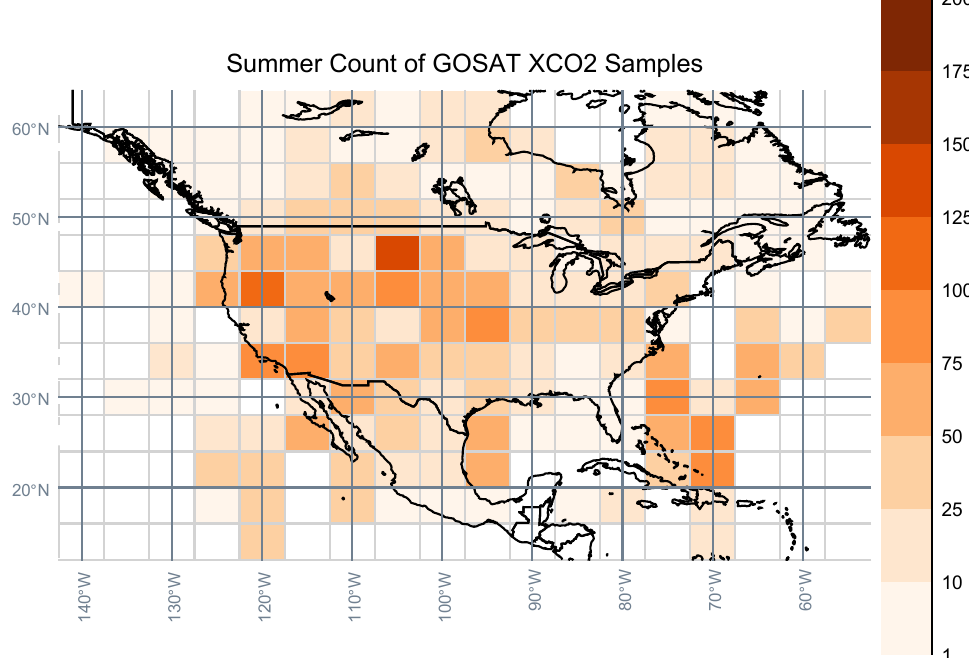
Figure A3. GOSAT XCO 2 sample counts for summer 2010 aggregated to the GEOS-Chem CMS-Flux grid (light gray lines).